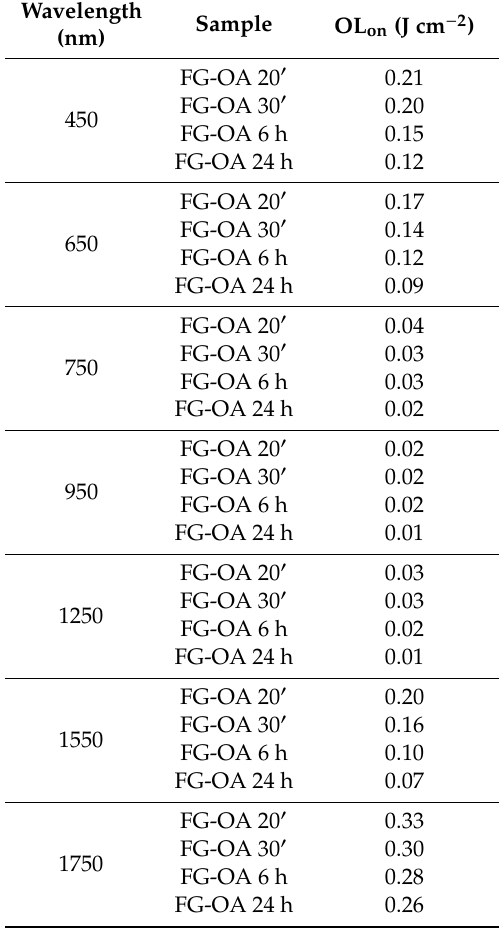
Table 4. Optical Limiting onsets of FG-OAxs under 450, 650, 750, 950, 1250, 1550 and 1750 nm laser